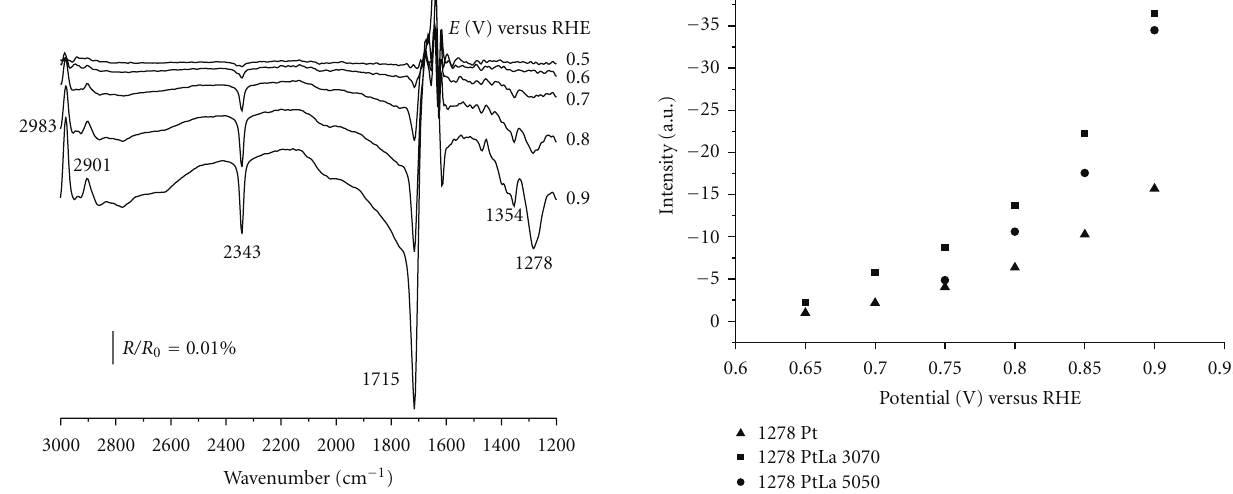
Figure 4: Potential dependence of the integrated band intensity (1278cm − 1 ) from Figure 3 corresponding to acetic acid, for Pt/C, PtLa/C (50 :50), and PtLa/C (30:70) electrocatalysts.